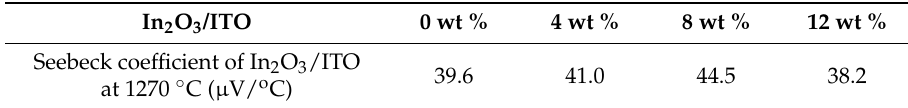
Table 2. Seebeck coefficients of In 2 O 3 /ITO thermocouples with different glass additives measured at 1270 ◦ C.